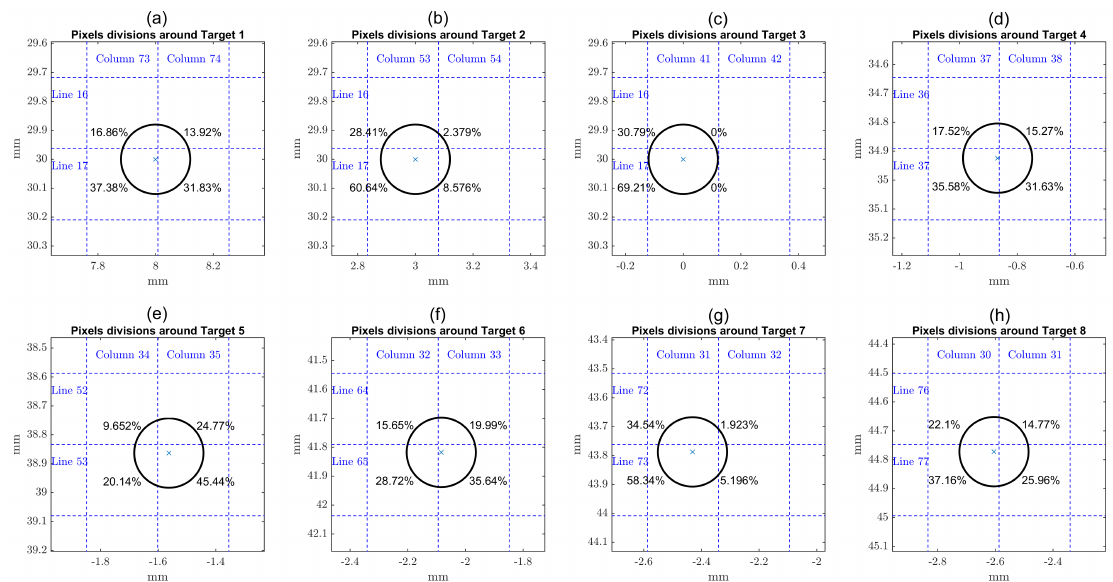
Figure 8. Schematic view of targets in the pixels grid.